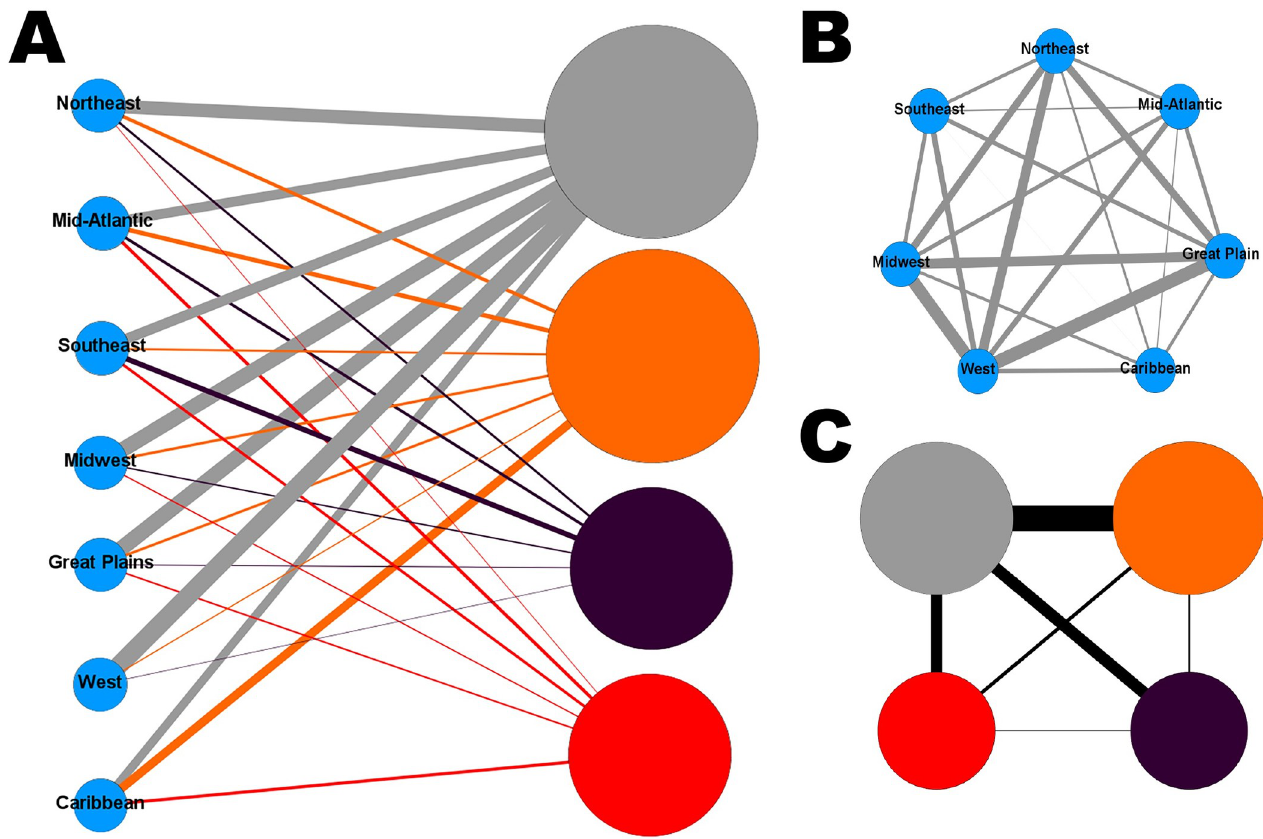
Fig 4. Bipartite network and projections with snake species grouped by region for snakes sampled for ophidiomycosis on military installations. Blue nodes represent regions of the US. The gray node represents the ophidiomycosis negative category, the orange node represents possible ophidiomycosis, the dark purple node represents Ophidiomyces present, and the red node represents apparent ophidiomycosis. Ophidiomycosis category node size is proportional to the prevalence of the category. (A) Bipartite network with one set of nodes representing seven US regions and the other set representing ophidiomycosis categories. Nodes are connected if snakes from a given region were classified into the given ophidiomycosis category, and the links are weighted based on the proportion of snakes of the given region in the given category, (B) Region-region network projection with region nodes connected if they share a connection with an ophidiomycosis category, (C) Disease-disease network projection with ophidiomycosis nodes connected if they share a link with a region.